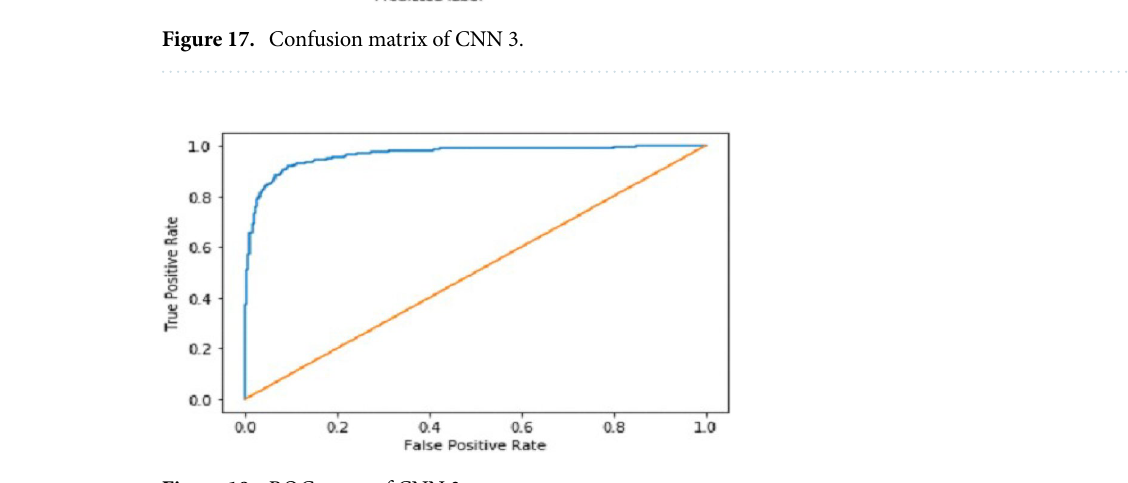
Figure 18. ROC curve of CNN 3.